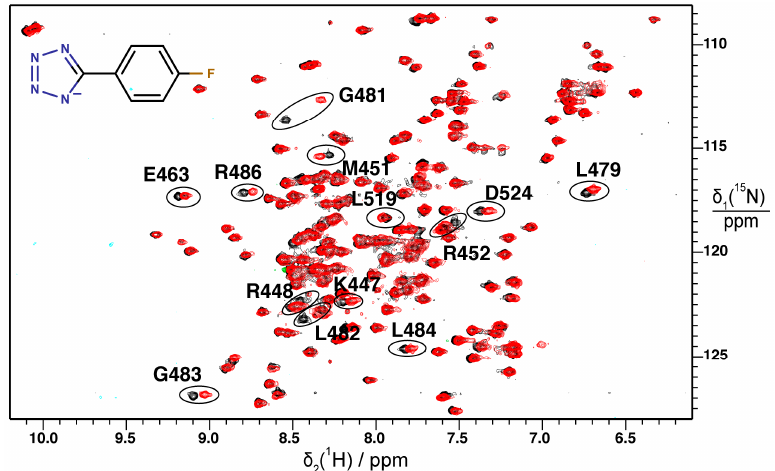
Figure 1. Superimposition of 15 N– 1 H HSQC spectra of DnaGC. The protein spectrum in the absence of fragment in black is compared with its spectrum after addition of fragment 4 (structure shown) in red. Representative assignments of resonances that showed the highest weighted chemical shift perturbation (CSP) (Figure S3d) are shown.